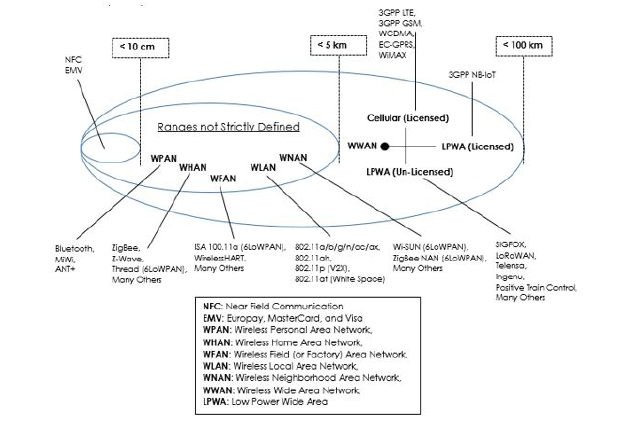
Figure 5. Access Technologies and Distances (Inspire on the Cisco book: IoT Fundamentals) A large amount of data will be put into play to the point that its management and processing exceed those of conventional computer tools for database management or information in general.